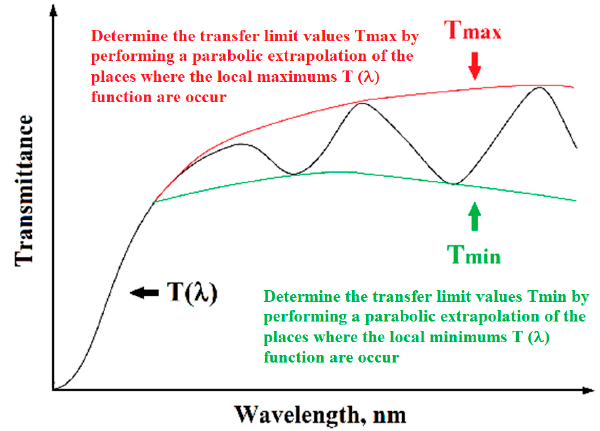
Figure 2. Schematic spectrum of transmittance as a function of the wavelength of a thin layer on a transparent substrate with visible local interference maxima and